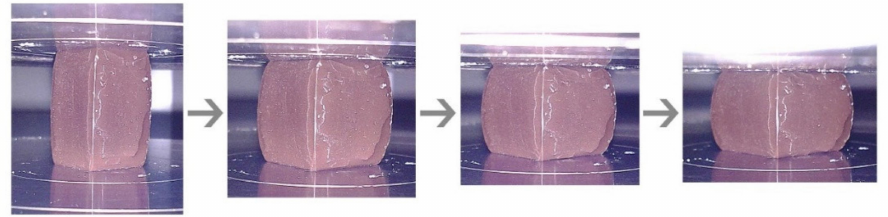
Figure 12. Ductile material (sample S5) during compressive strength.